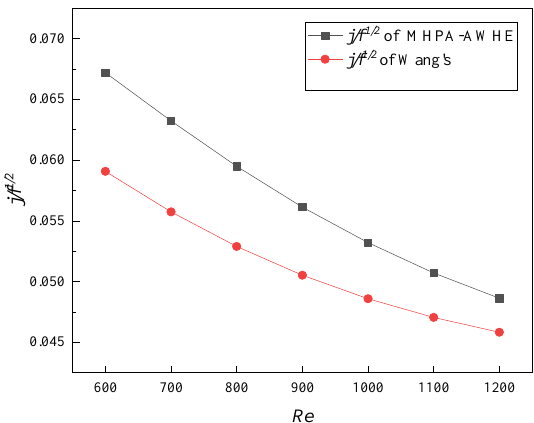
Figure 22. Distribution of comprehensive performance index j/f 1/2 for different Re.